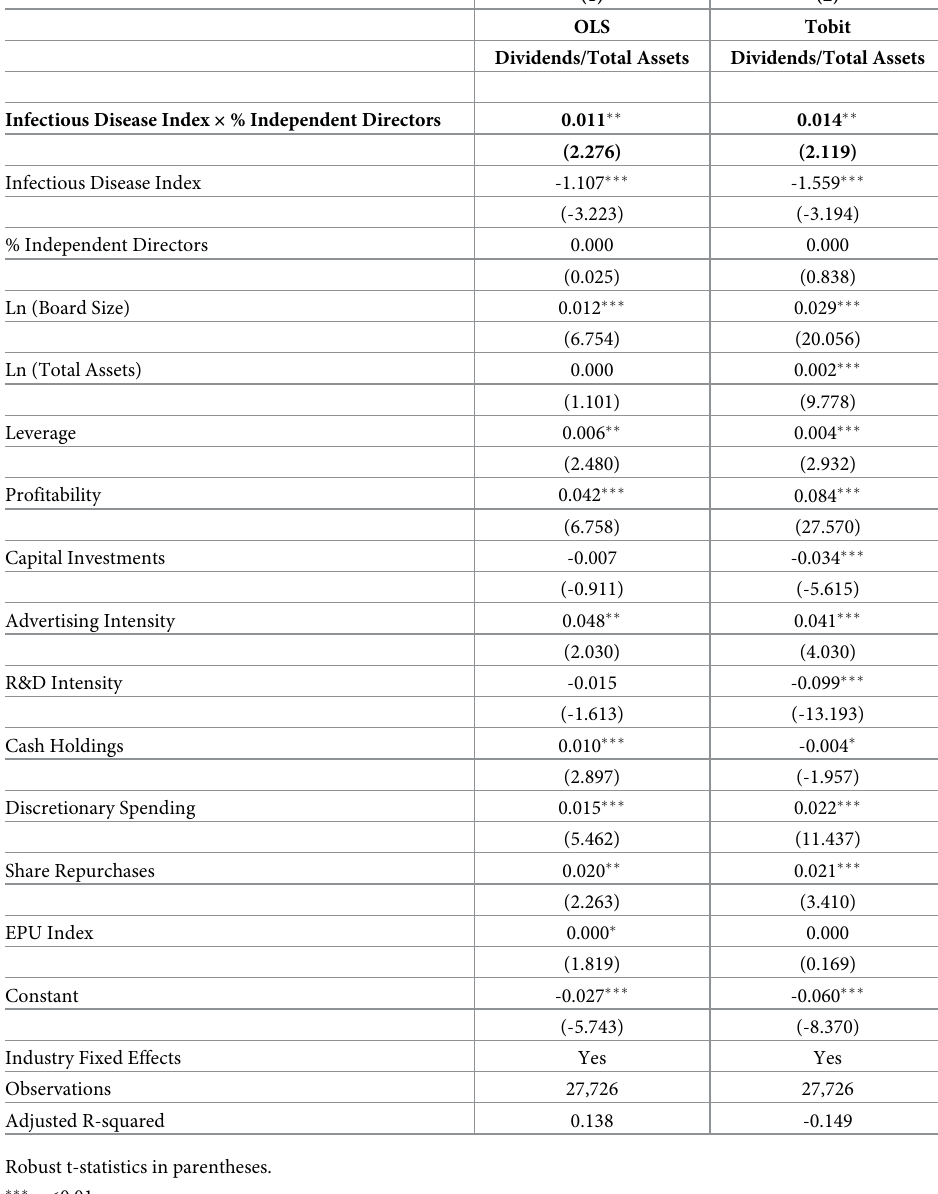
Table 8. The effect of independent directors on dividends in the presence of infectious diseases. Our measure of disease-related uncertainty is the infectious disease equity market volatility developed by Baker et al. (2020) [9]. Using sophisticated textual analysis, Baker et al. (2020) [9] search for news articles related to infectious diseases and equity market volatility. A higher fraction of these news articles to all articles in each time period signifies a higher level of market uncertainty that can be ascribed to infectious diseases. For ease of interpretation, we have the infectious disease equity market volatility index divided by